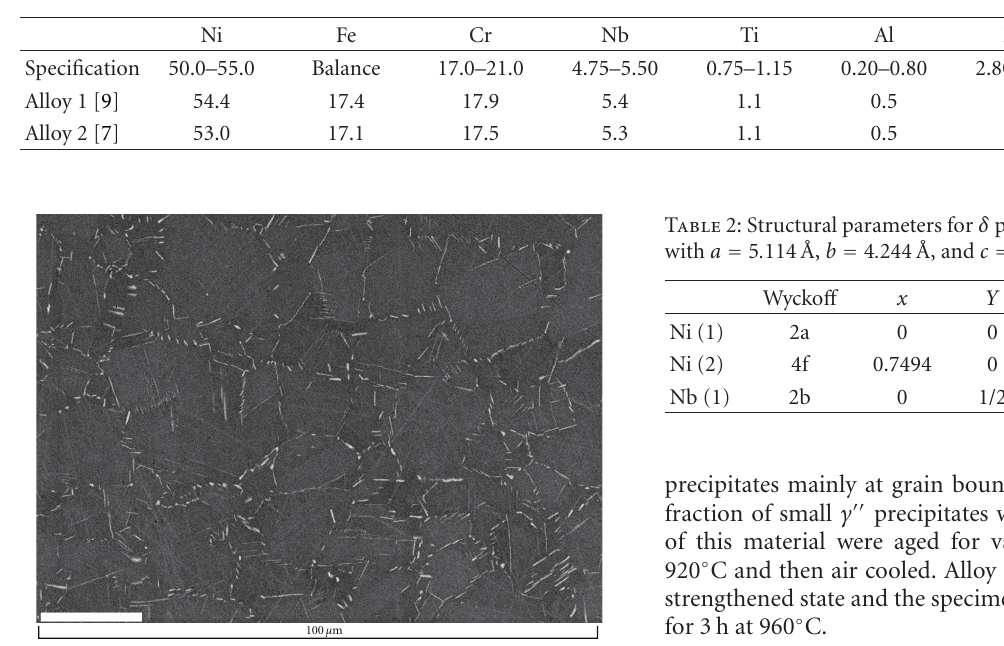
Table 1: Specification (wt.%) of alloy 718 [8] and composition of the alloys used in the present study [7, 9].